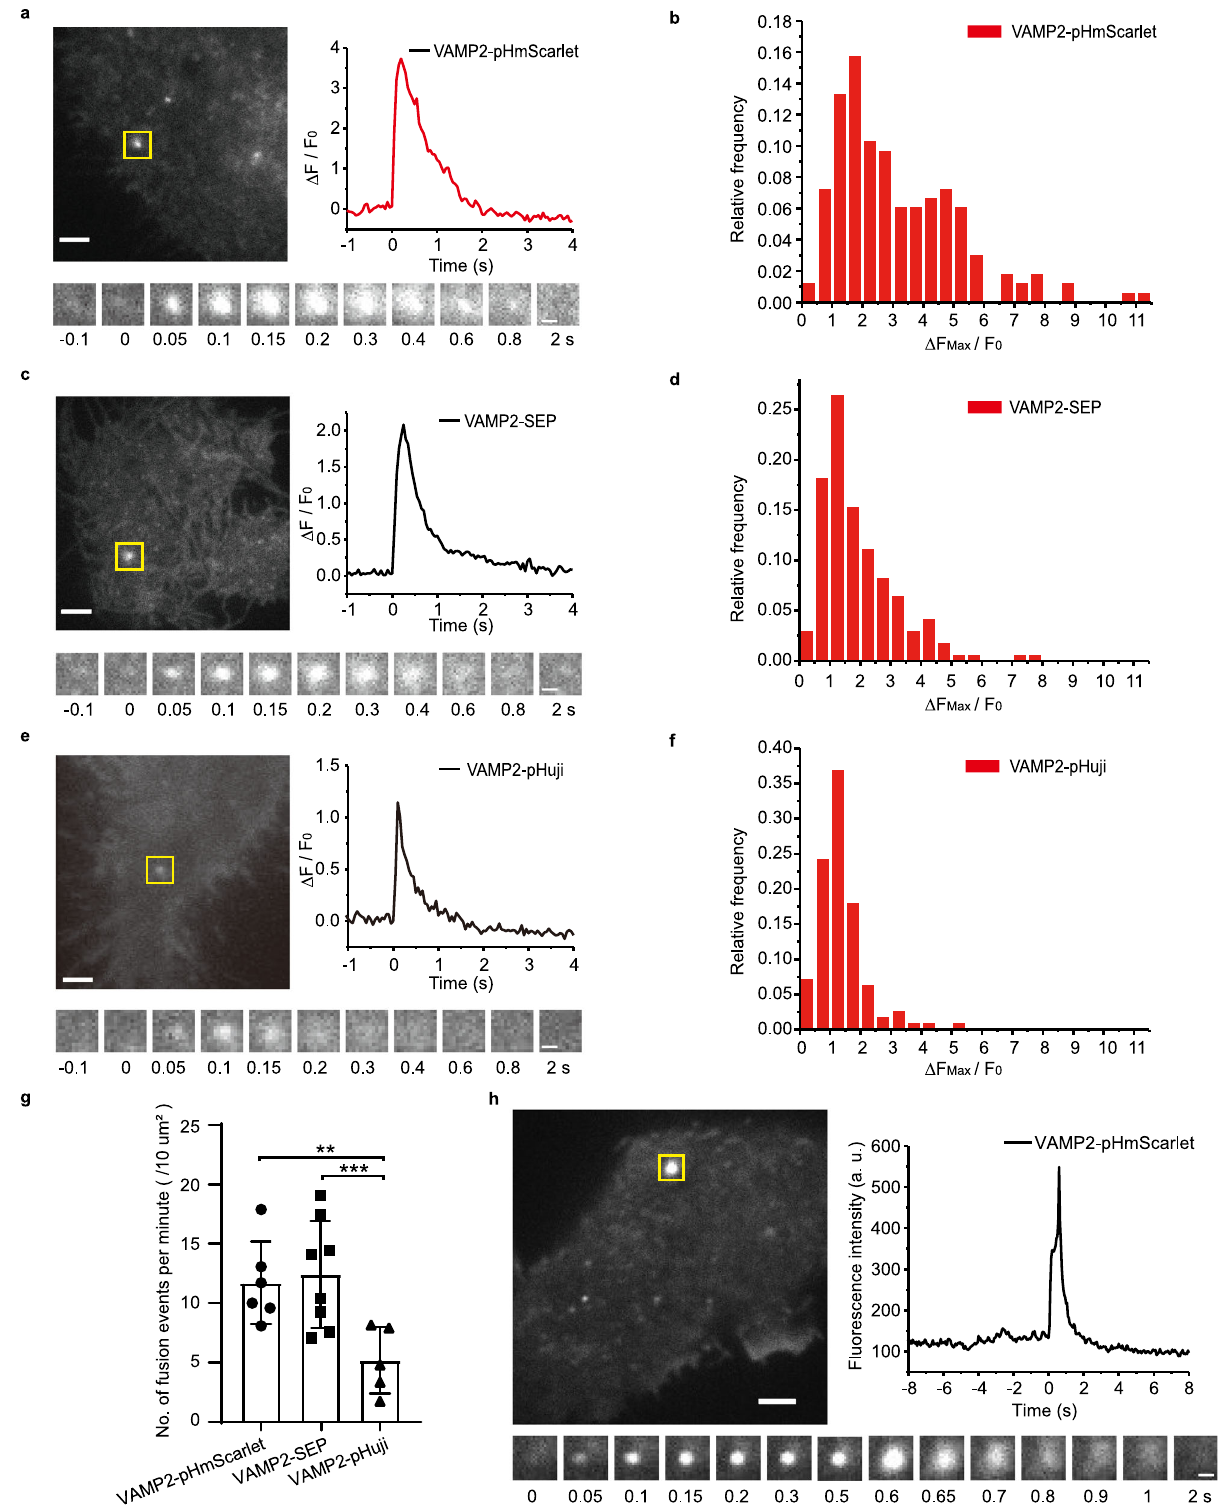
initial rise in fl uorescence intensity due to the opening of stimulated fusion pores, followed by a fl uorescence decay due to the diffusion of VAMP2-pHmScarlet in the plasma membrane. When co-expressing with SEP and pHmScarlet or SEP and pHuji, the ability to detect individual exocytotic events labeled by pHmScarlet was comparable to that of SEP (Supplementary Fig. 5). In primary mouse hippocampal pyramidal neurons, single